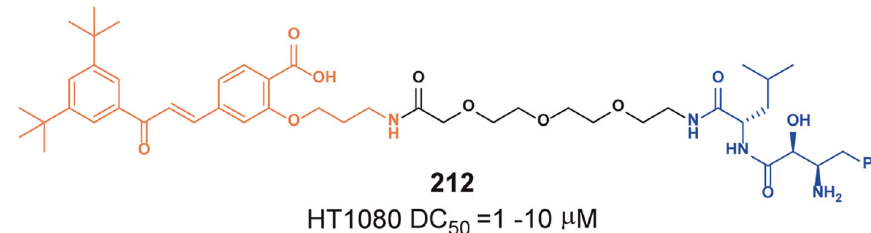
Fig. 65 The representative PROTAC targeting RAR